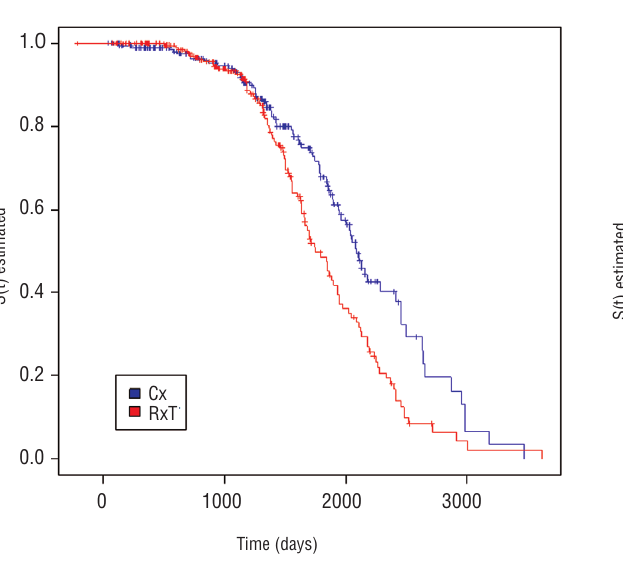
Figure 2 - Disease-free-survival curve (Kaplan-Meier estimates) for RP.